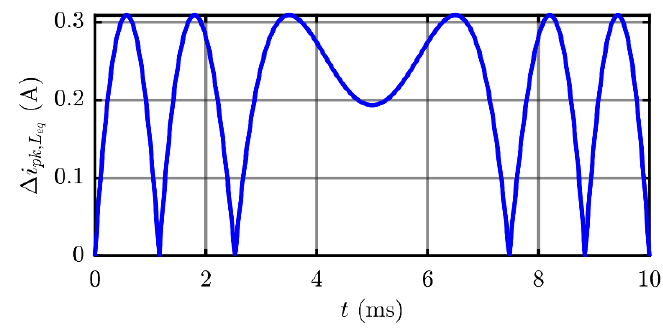
Figure 7. Current ripple peak behavior in the case of L eq = 300 μH.